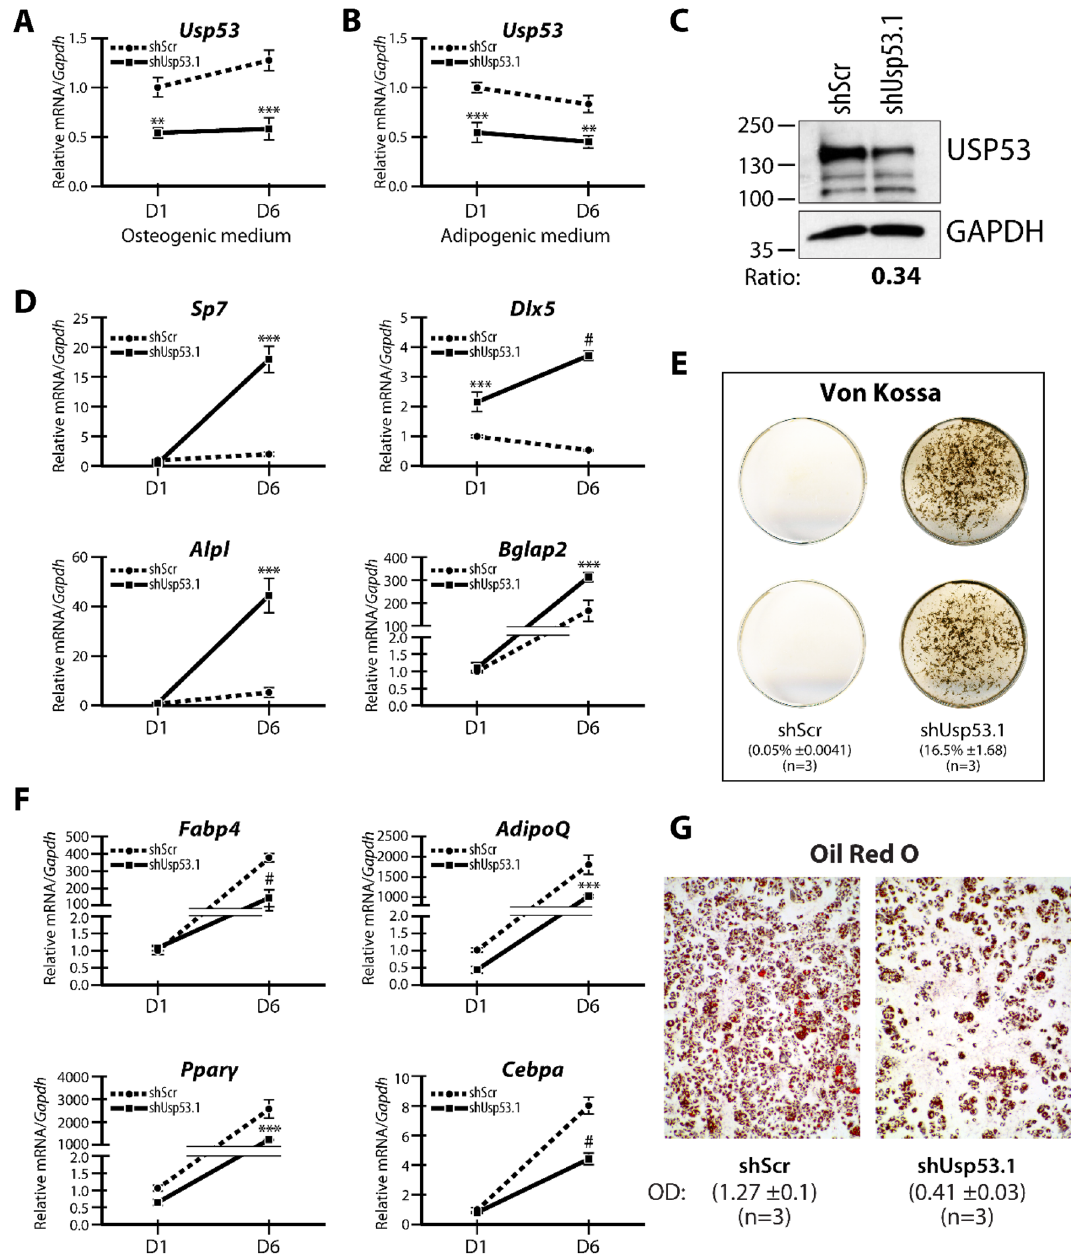
Figure 5. Usp53 knockdown with a different shRNA confirms the impact on osteogenic and adipogenic fate determination in vitro . ST2 cells expressing scrambled shRNAs (shScr) targeting control and shRNAs targeting Usp53 were grown under osteogenic conditions ( A ) or adipogenic conditions ( B ) for 6 days. ( C ) Immunoblot of whole cells extracts from ST2 cells stably expressing shRNA targeting Usp53 (shUsp53.1) and scrambled shRNA (shScr) as control. Membranes were probed with anti-USP53 and anti-GAPDH antibodies (as loading controls). Relative signal intensity quantified using ImageJ is shown below each lane. Full-length blots are presented in Supplementary Figure S6. Gene expression analysis of osteogenic ( D ) or adipogenic ( F ) differentiation markers. Quantitative RT-qPCR using TaqMan probes against osteoblast or adipocyte differentiation markers, normalized to Gapdh , was performed on RNA isolated from shScr-stably transfected (dashed line) or shUsp53- stably transfected (solid line) pools of ST2 cells grown for 6 days in osteogenic or adipogenic medium. ST2 cultures were examined for von Kossa staining at day 8 ( E ) or oil red O at day 6 ( G ). Results are presented as the mean fold change ± SD. ** P ≤ 0.01; *** P ≤ 0.001; # P < 0.0001; ANOVA with Bonferroni’s post-hoc test for all